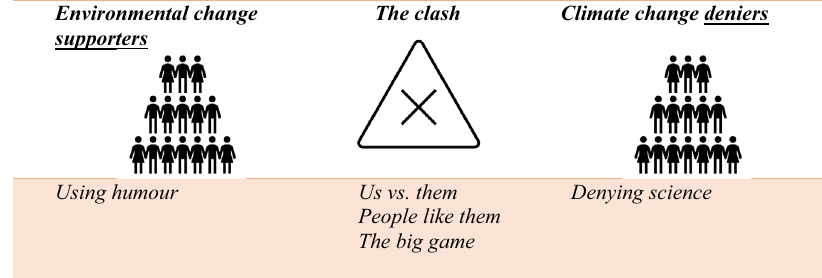
Fig. 1 Illustrating both the process of anti and pro-environment mobilisation online and the formation of digital identities